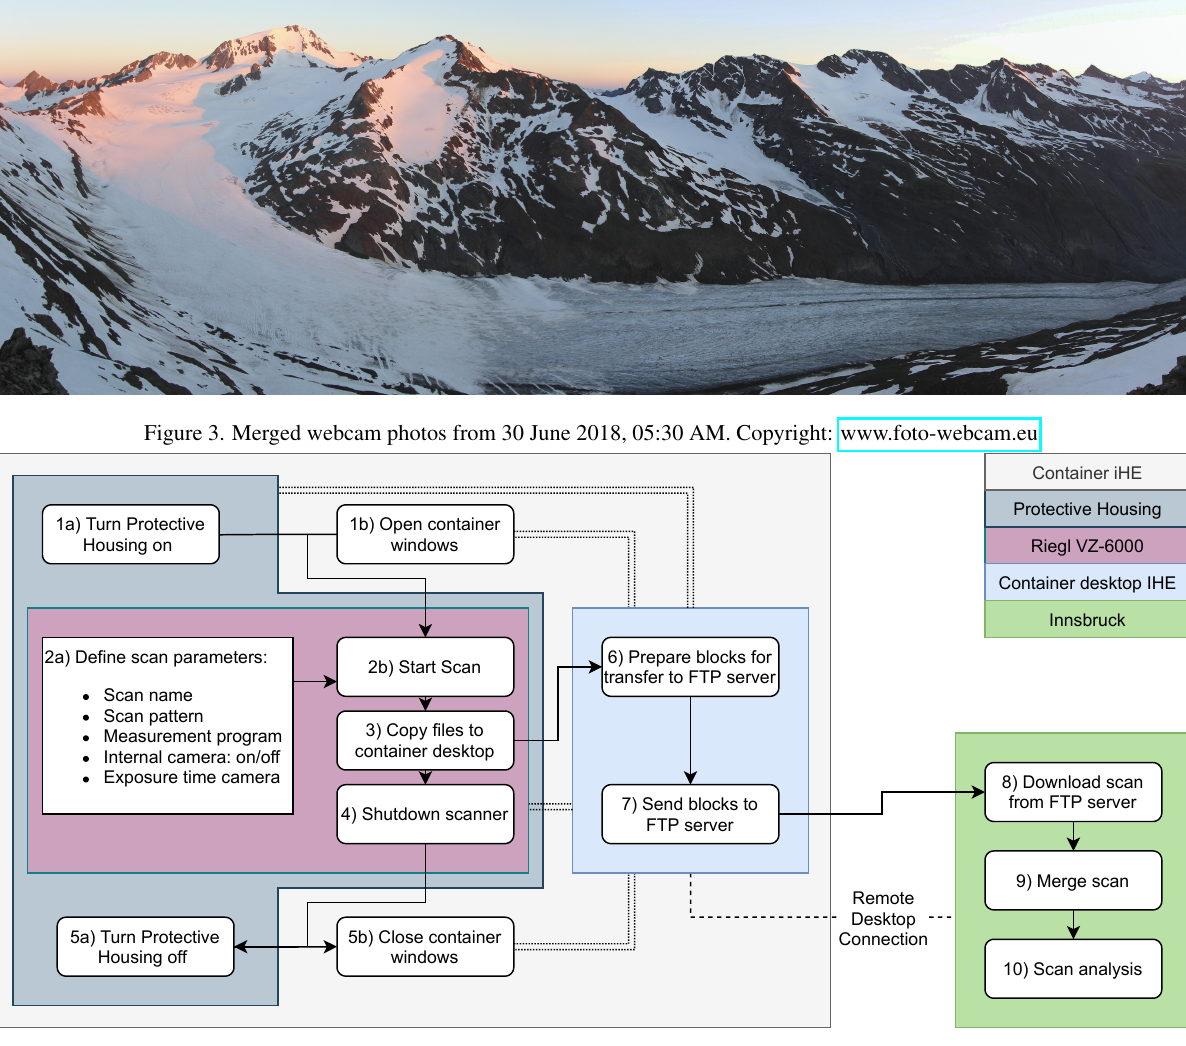
Figure 4. Flowchart of the automated scanning process at